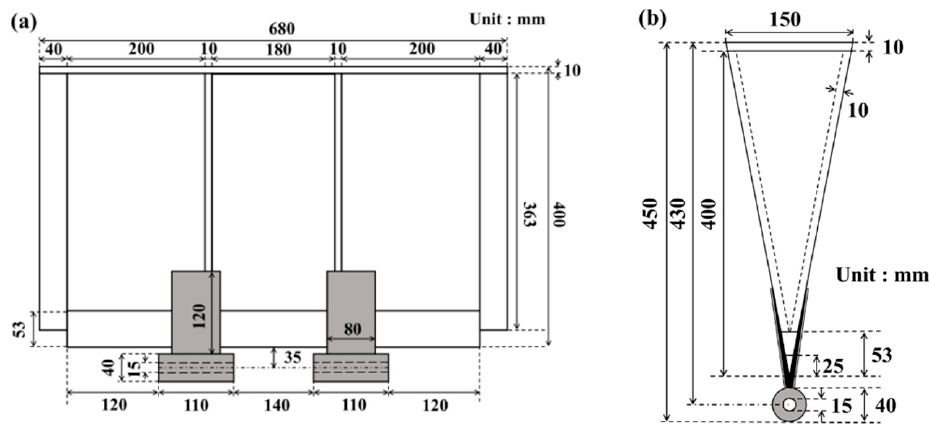
Figure 2. Flap design with an inverted triangular prism shape: ( a ) front view and ( b ) side view. A rack gear was attached to the upper part of the flap to operate a gear system connected to the rotary generators with the reciprocating motion of the flap. In a previous study by Morimoto and Mizutani [43], it was not possible to evaluate the power generation e ffi ciency in high wave height conditions because a rack gear with the shape of a straight rod attached to a flap was separated from the gearbox. Therefore, a curved, round rack gear, as depicted in Figure 3, was designed in this study so that the rack gear was hardly separated even in high